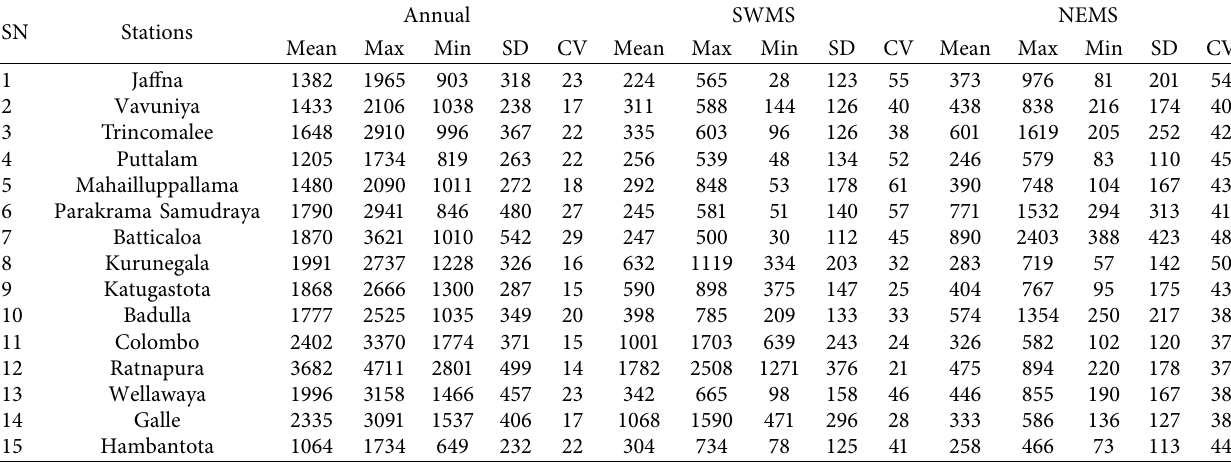
Table 3: Summary of the annual and seasonal rainfall of the Sri Lanka